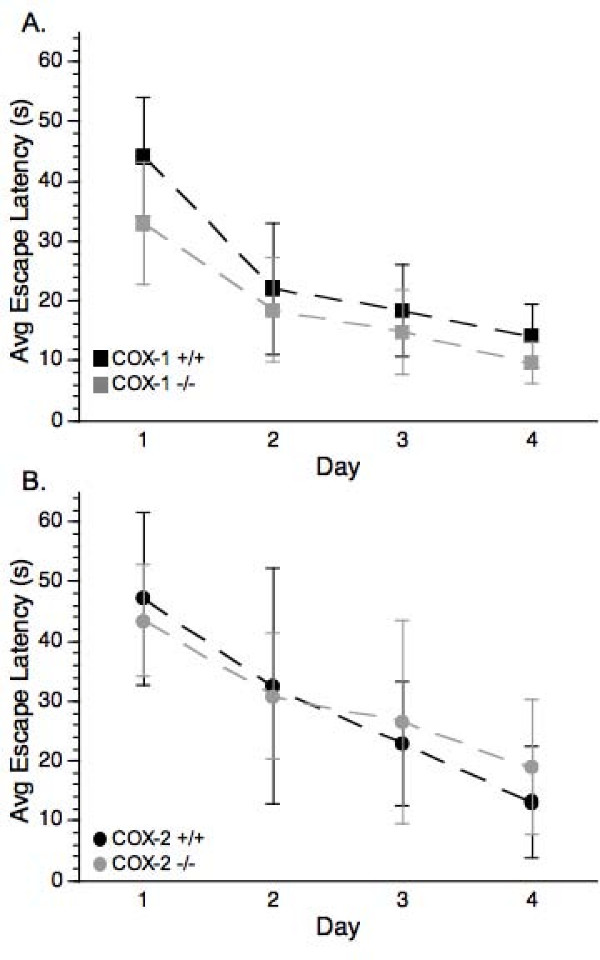
Assessment of pre-injury spatial learning ability as determined by the MWM. (A) COX-1 +/+ and COX-1 -/- mice or (B) COX-2 +/+ and COX-2 -/- mice showed a significant day effect (ANOVA P < 0.05) indicating that each genotype was able to learn the location of the hidden platform. Data are presented as mean ± SD.